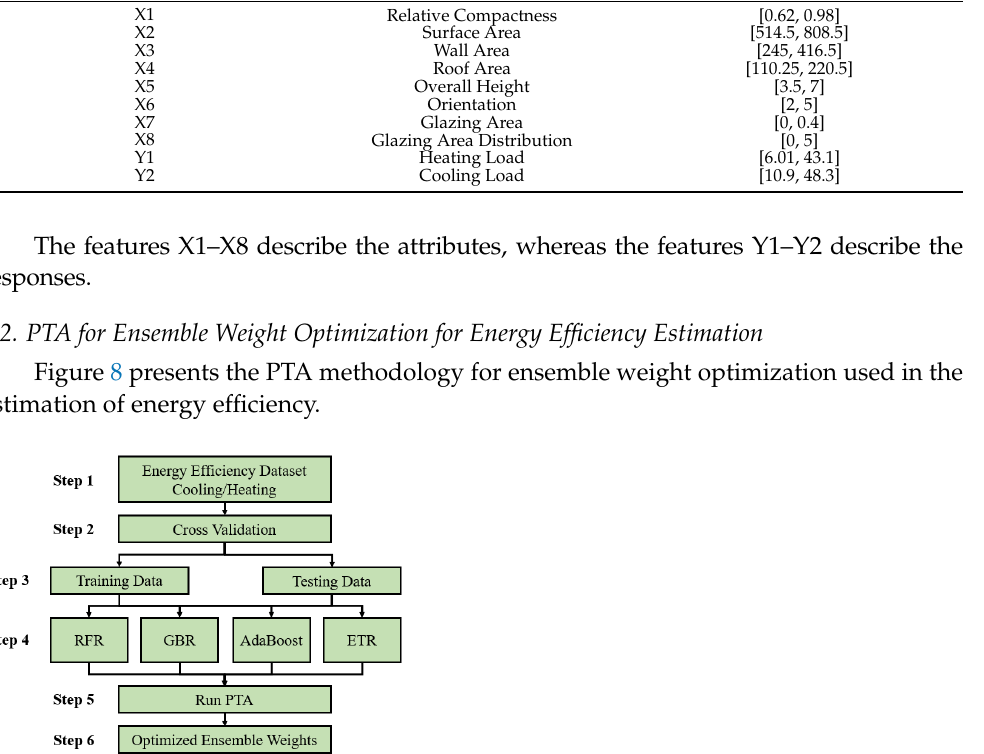
Table 8. Energy Efficiency Dataset Attribute Information Summary.